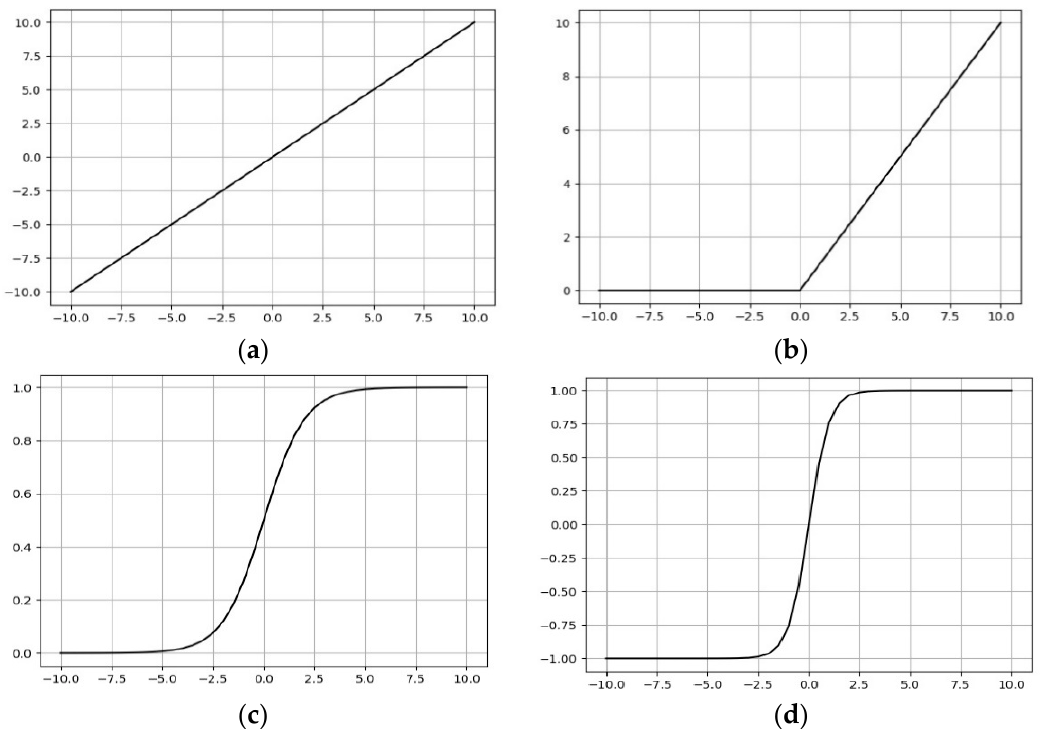
(cid:0) (cid:1) 1 + e − Z ; ( d ) hyperbolic tangent (tanh): g ( Z ) =